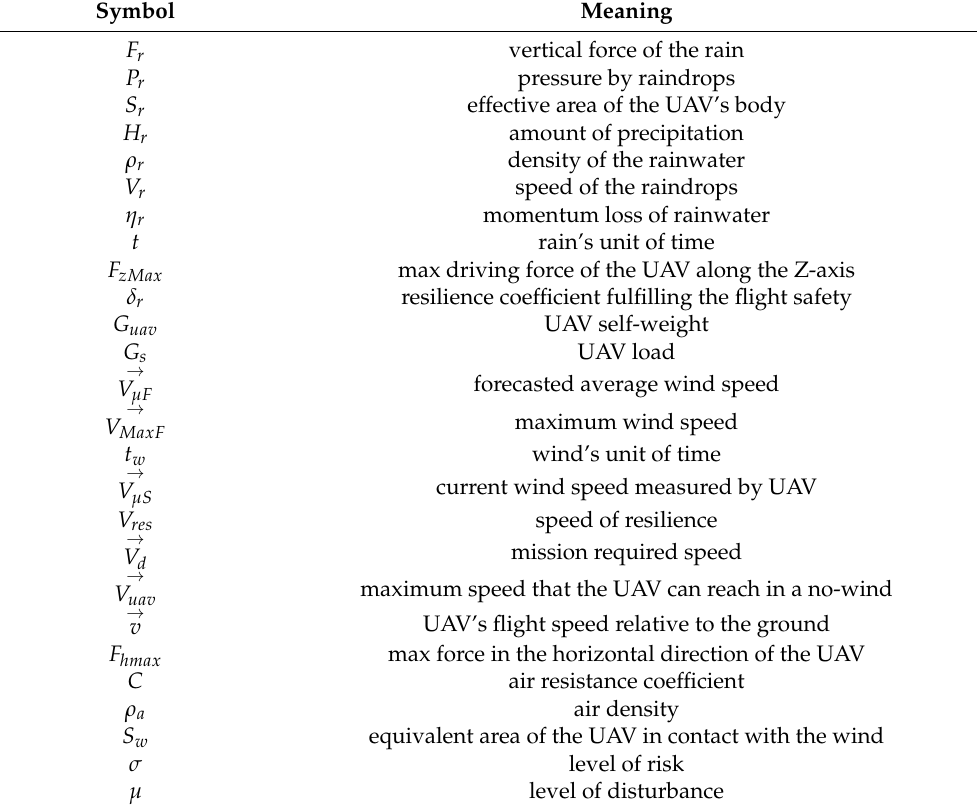
Table A1. Symbols that appear in this